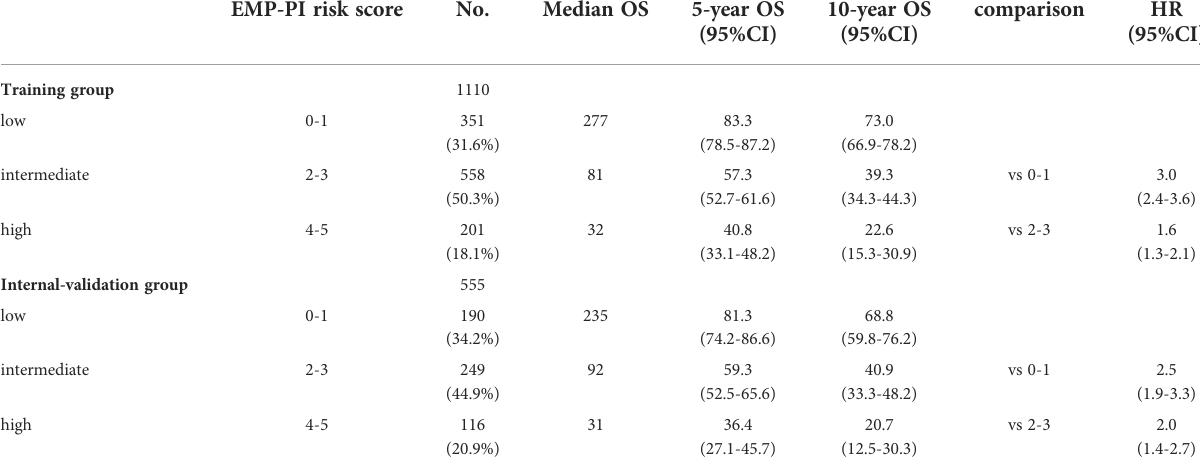
TABLE 3 Survival data of three risk groups based on EMP-PI in the training and internal-validation